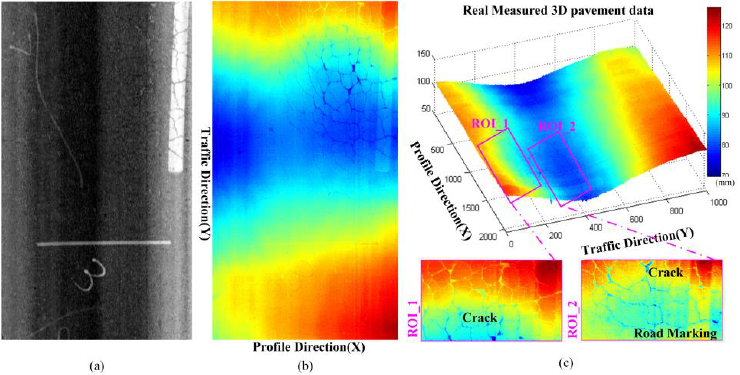
Figure 2. The 2D pavement image and corresponding 3D laser scanning data (with crack, road marking and deformation), ( a ) 2D pavement image, ( b ) real measured 3D laser scanning data, ( c ) 3D laser scanning data and some local ROI illustrations.